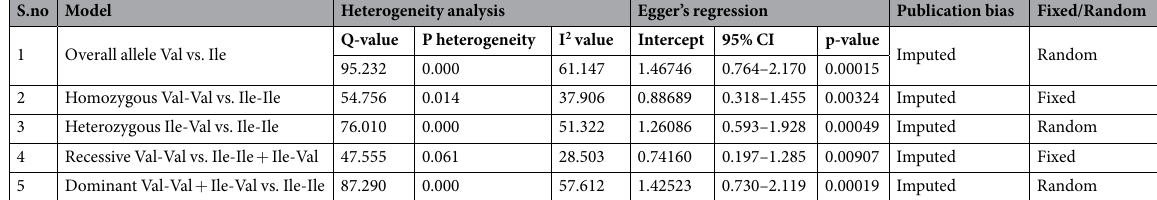
Table 2. Statistics for heterogeneity analysis and publication bias.